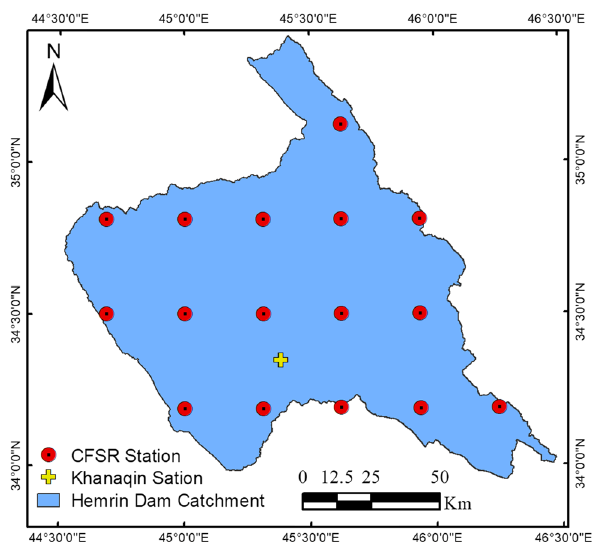
Fig. 9 Positions of CFSR and Khanaqin weather stations in the Hem- ren dam reservoir catchment